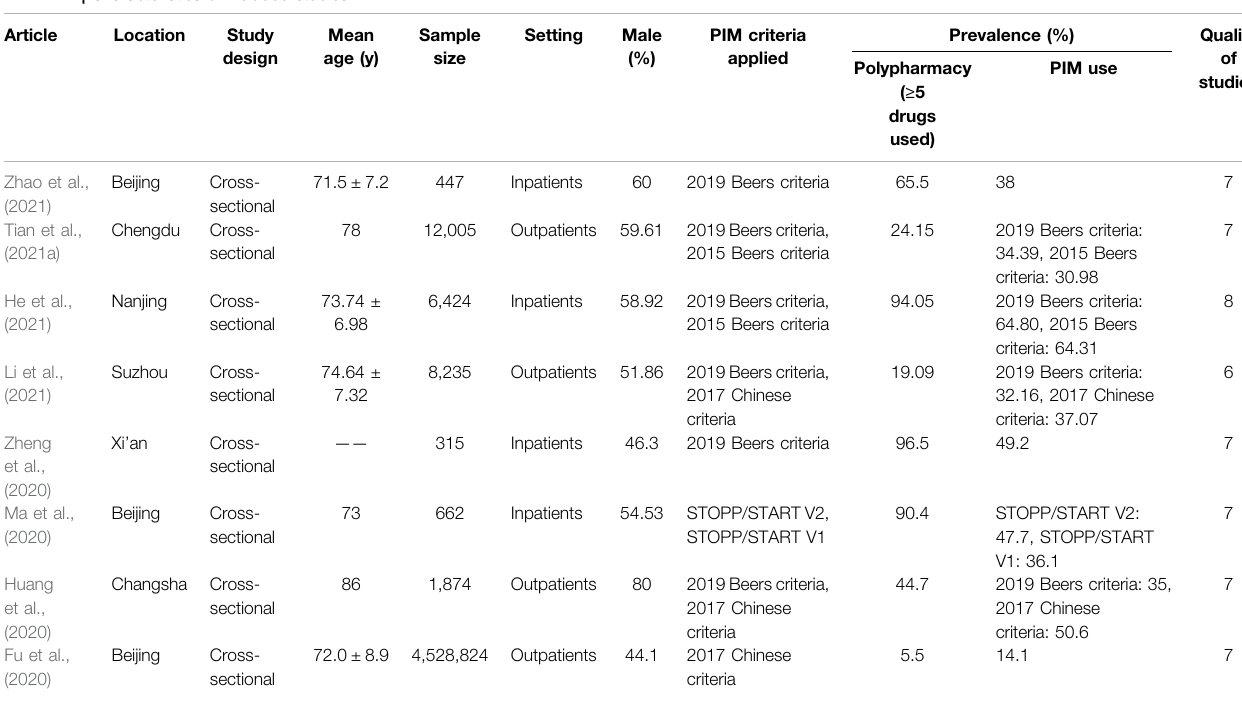
TABLE 1 | Characteristics of included